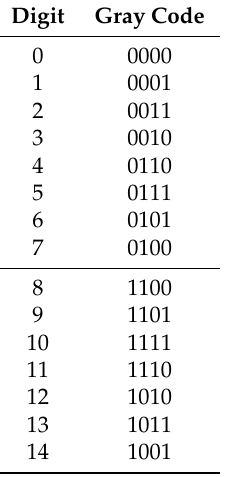
Table 4. 4-bit Gray